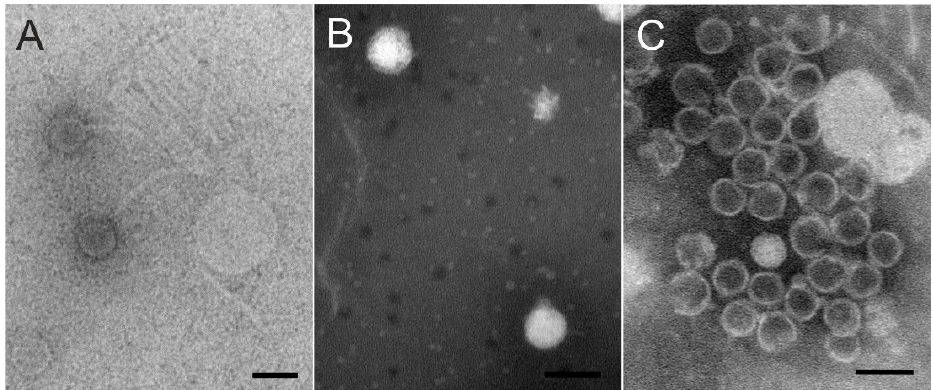
Figure 4. Negatively stained phage particles under transmission electron microscope. ( A ) Lumi ( B ) Kuura and ( C ) Tiera. Scale bar is 100 nm.